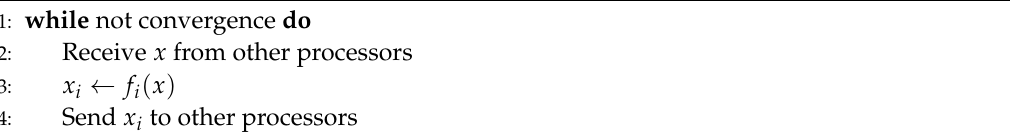
Algorithm 1 Asynchronous iterations with asynchronous communication.